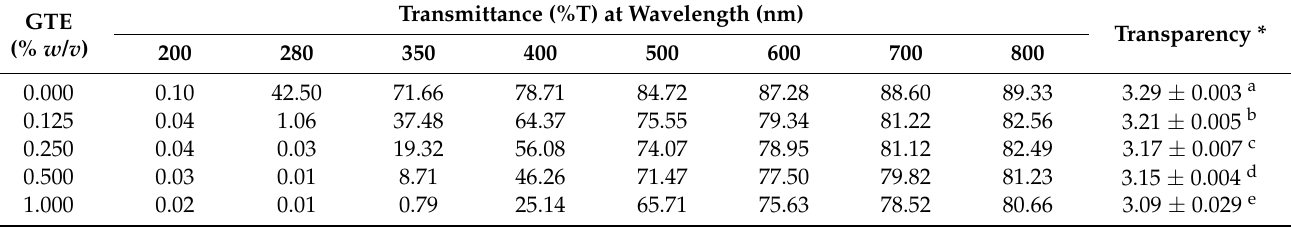
Table 2. Light transmission and transparency of rice-starch-pectin films incorporated with green tea extract at different